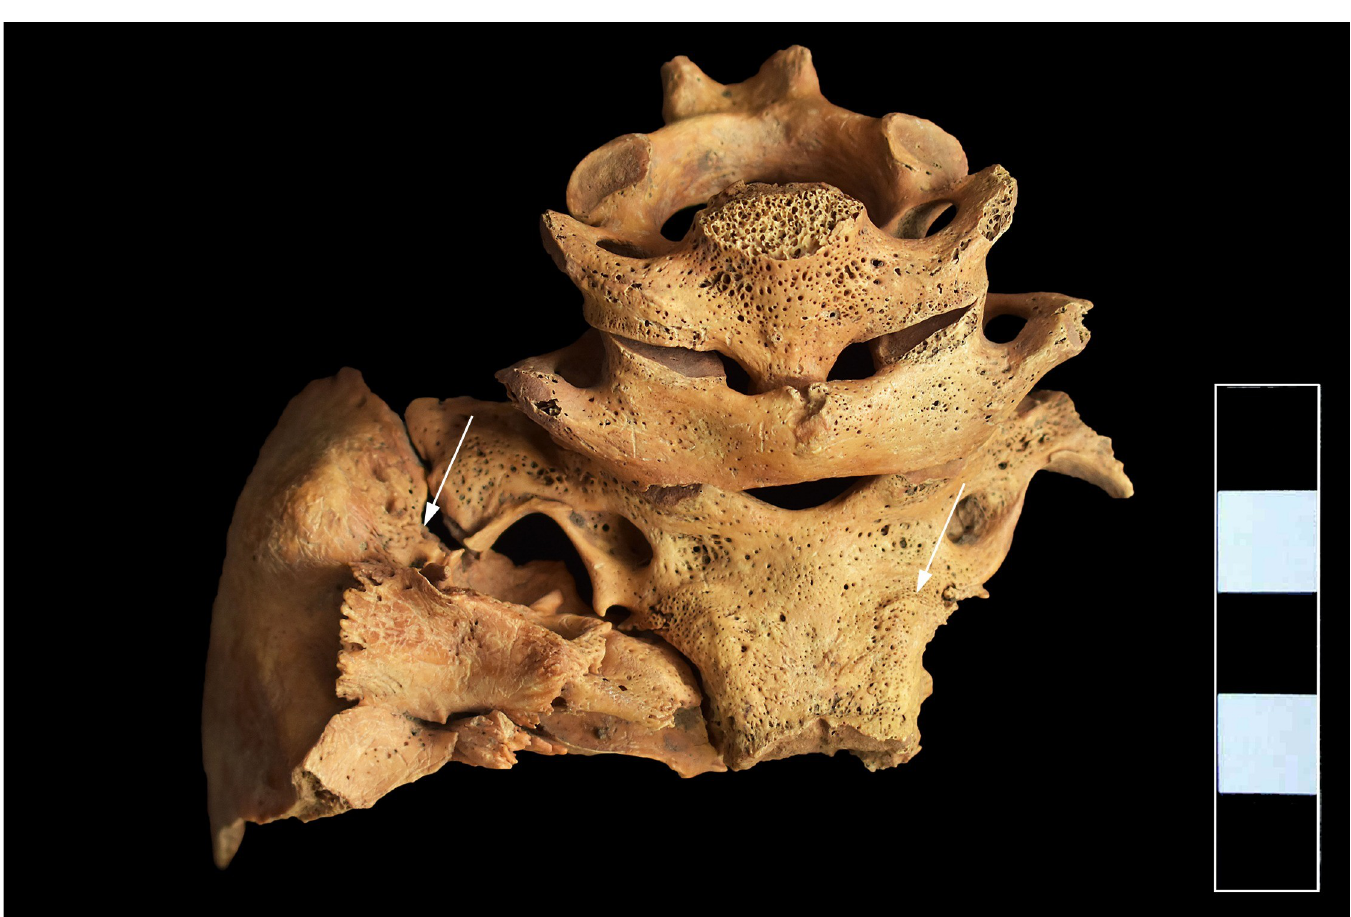
Fig 4. Pitting and slight cortical remodeling on the ectocranial surface of the occipital and left temporal bones (white arrows).